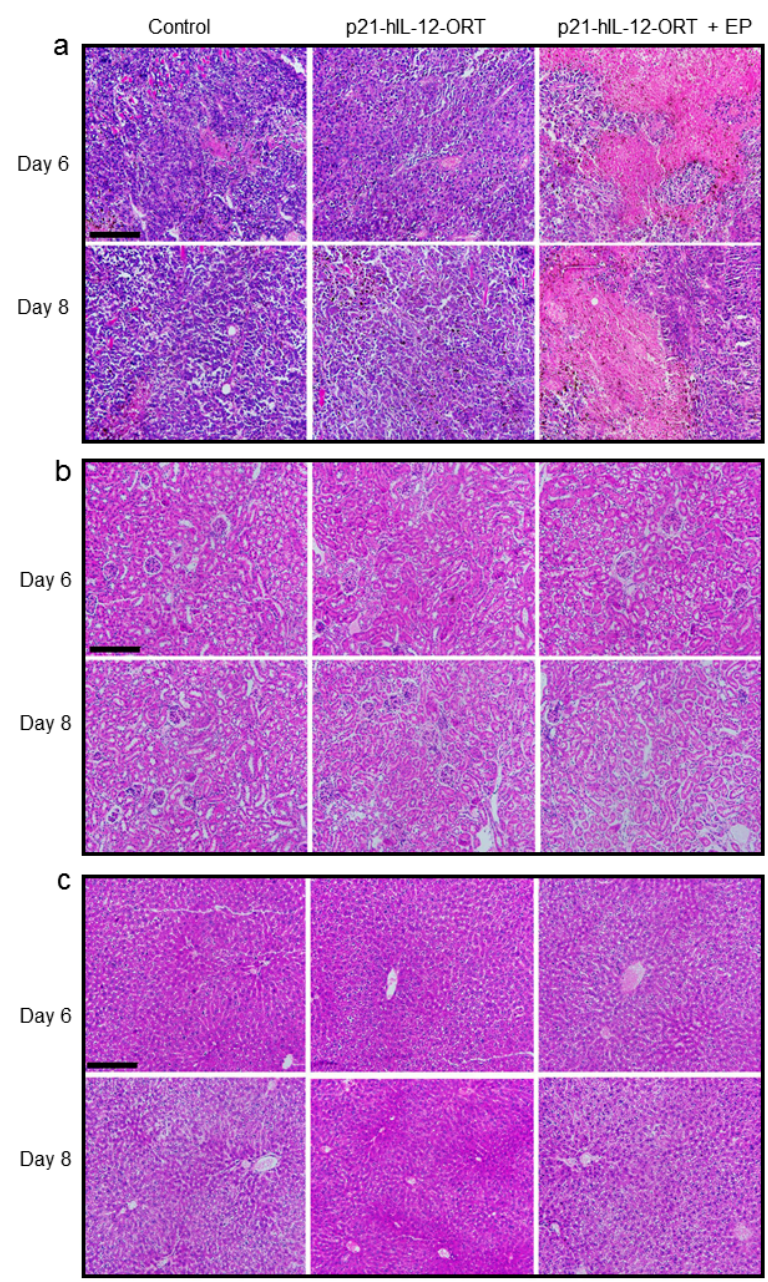
Figure 3. Histological changes in tumor kidney and lung tissue section, 6 and 8 days after p21-hIL- 12-ORT GET in mouse B16F10 melanoma tumors. ( a ) Tumor necrosis in mouse B16F10 melanoma tumor sections; ( b ) Histological changes in kidney tissue; ( c ) Histological changes in lung tissue . Representative images of 2 µm thick paraffin embedded sections stained with hematoxylin and eosin. Images were taken at days 6 and 8 with a DP72 CCD camera (Olympus, Tokyo, Japan) connected to a Bx-51 microscope (Olympus). Scale bar 200 µm.